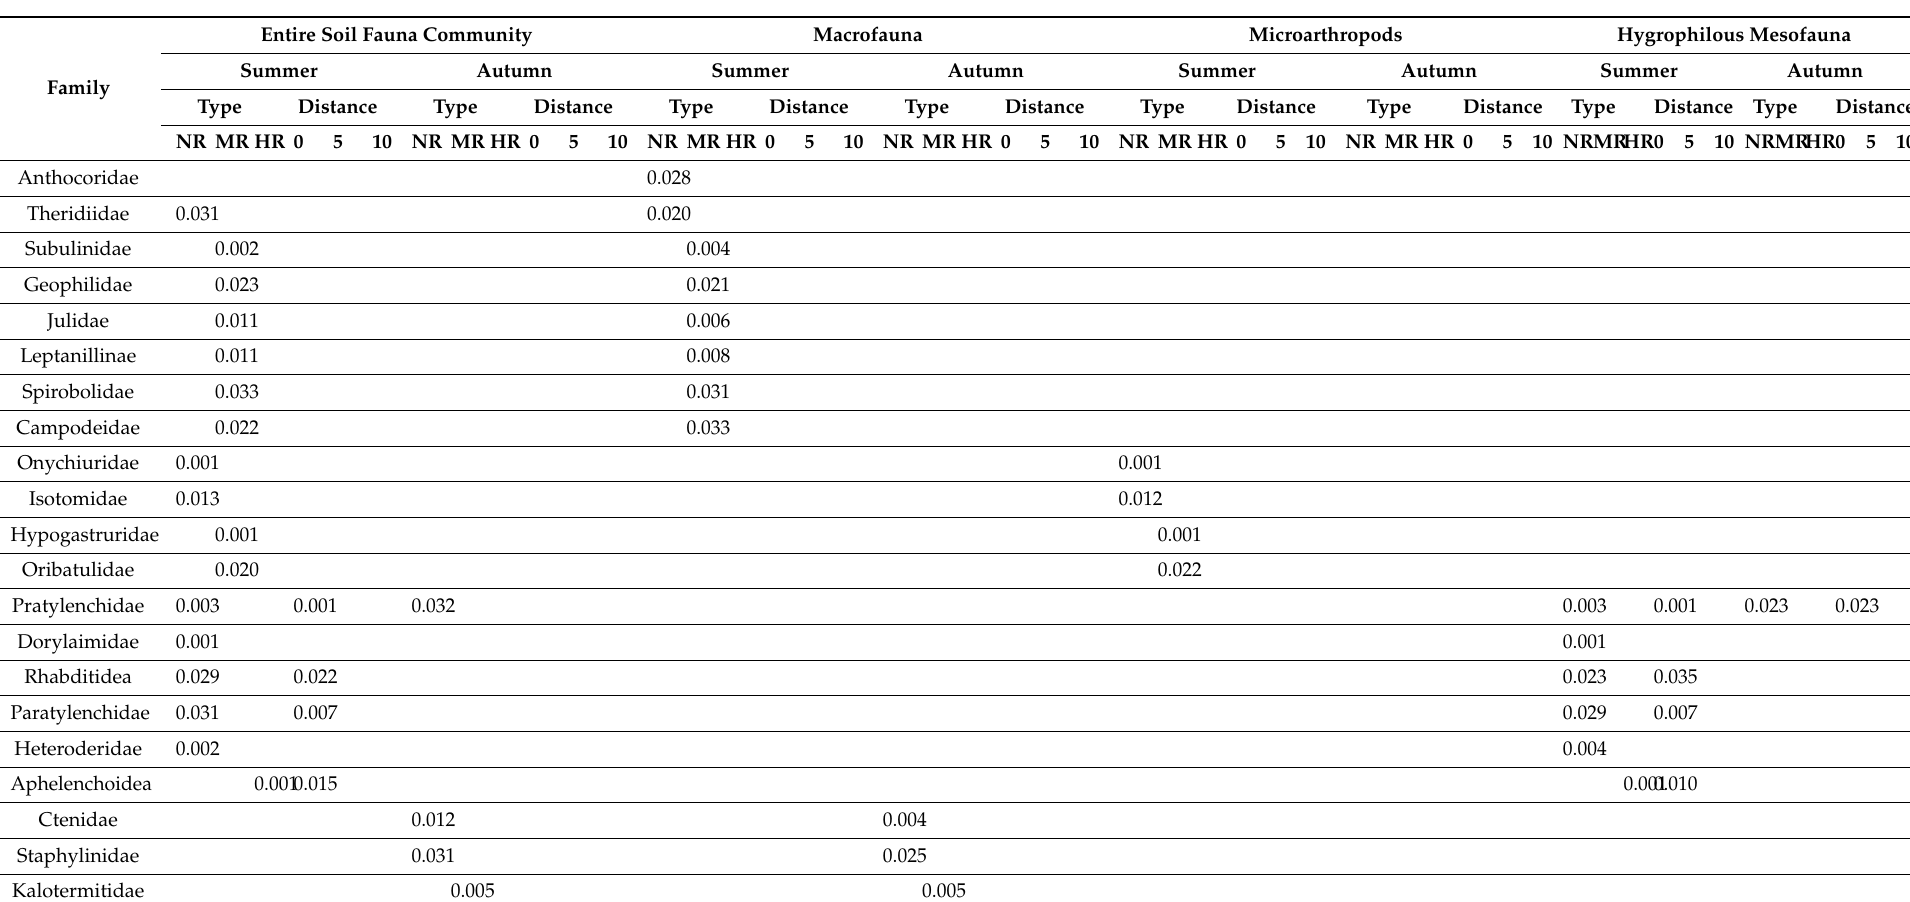
Table A7. p values of indicator taxa for revetment types and distances in two